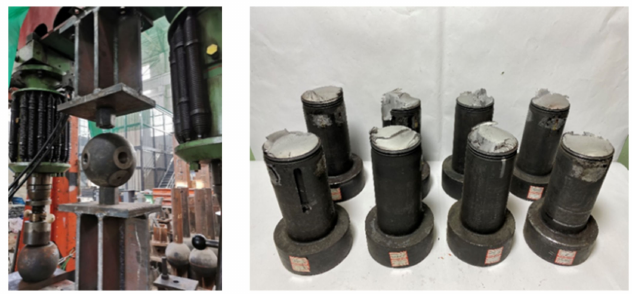
Figure 7. The M60 high-strength bolts that failed under fatigue